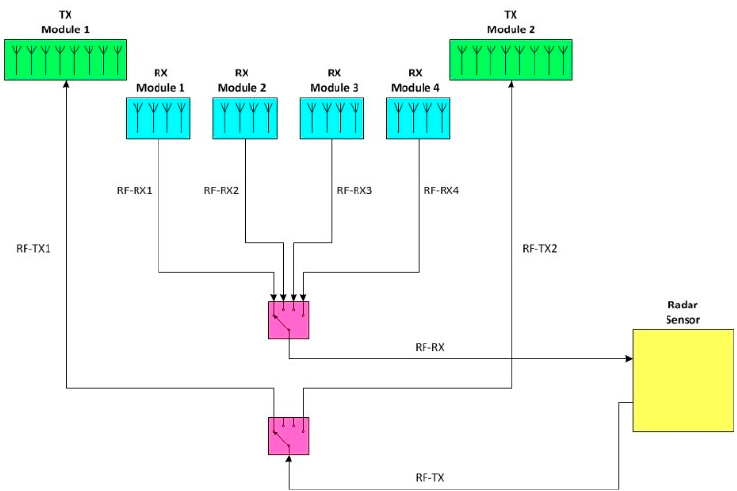
Figure 4. SPARX array block diagram.